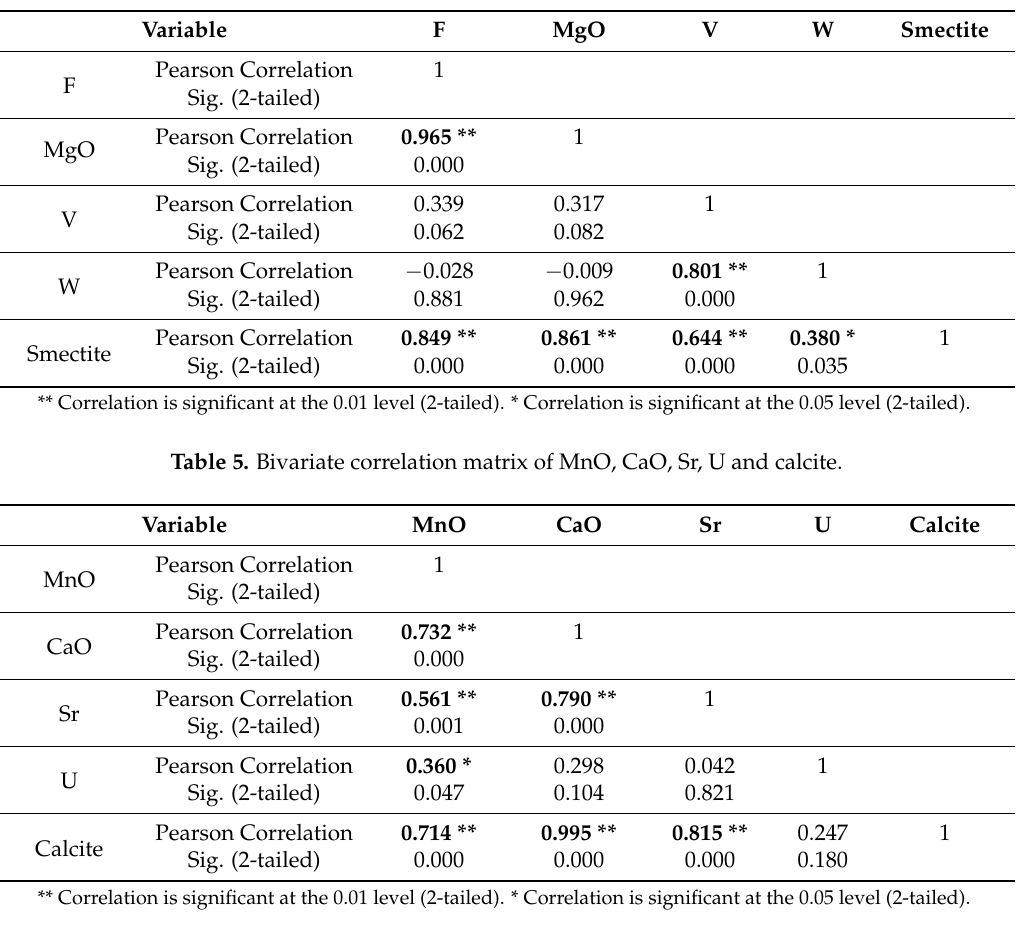
Table 4. Bivariate correlation matrix of F, MgO, Ag, In, V, W and smectite.